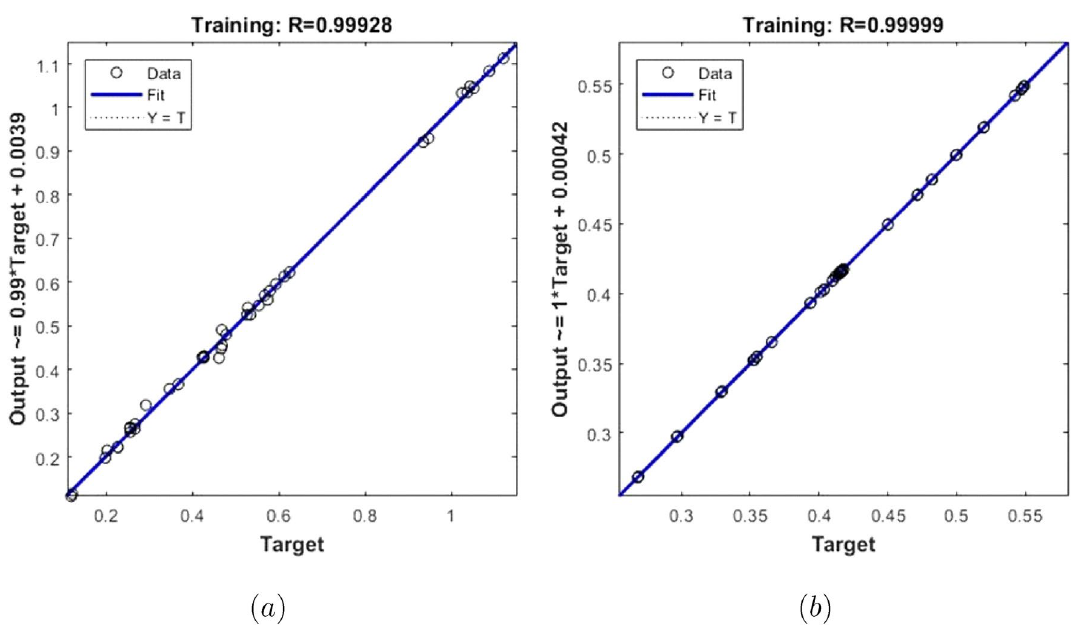
Figure 17. Training data ( a ) Skin Friction Coefficients ( b ) Nusselt